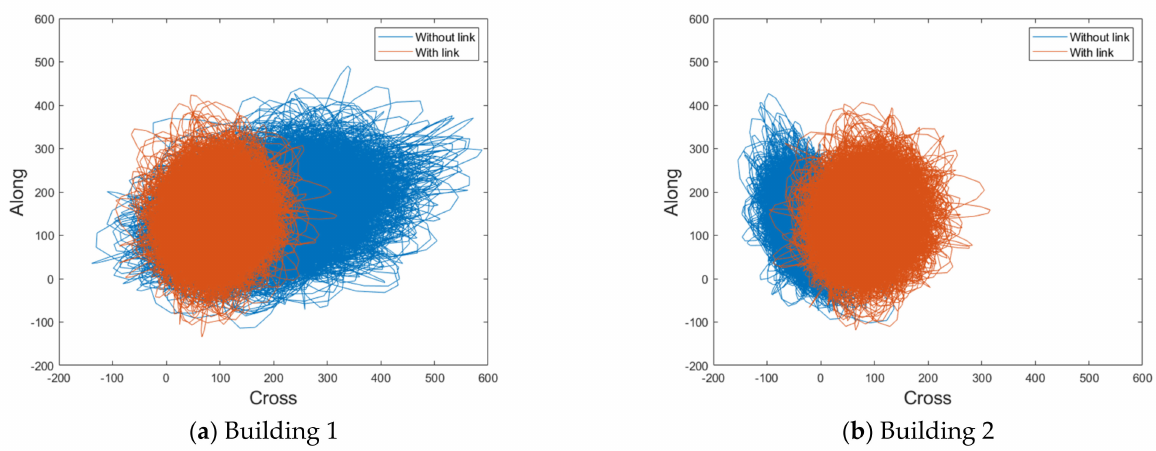
Figure 17. Trajectories of lateral displacement with a small gap distance (unit: mm).